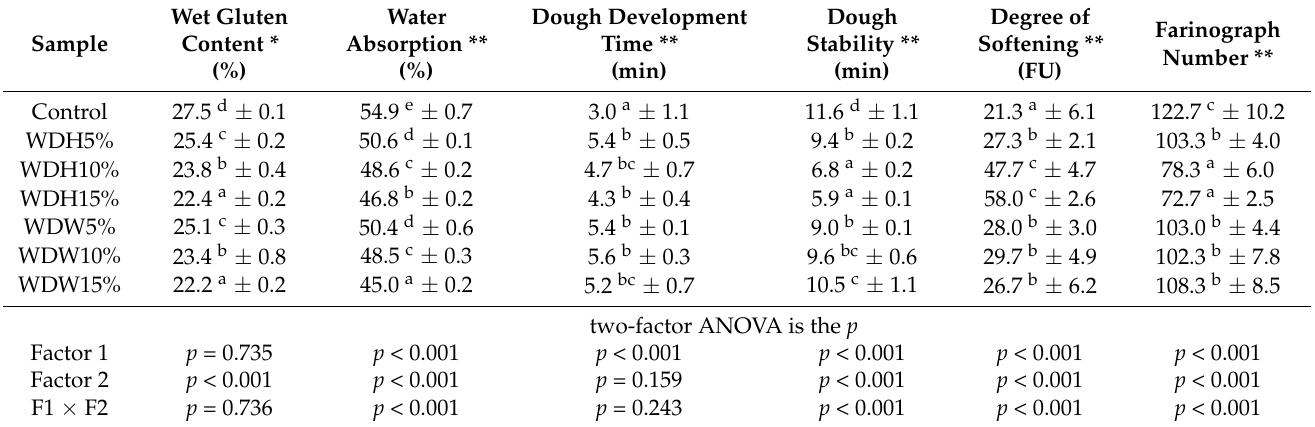
Table 1. Wet gluten content and farinographic properties of the tested